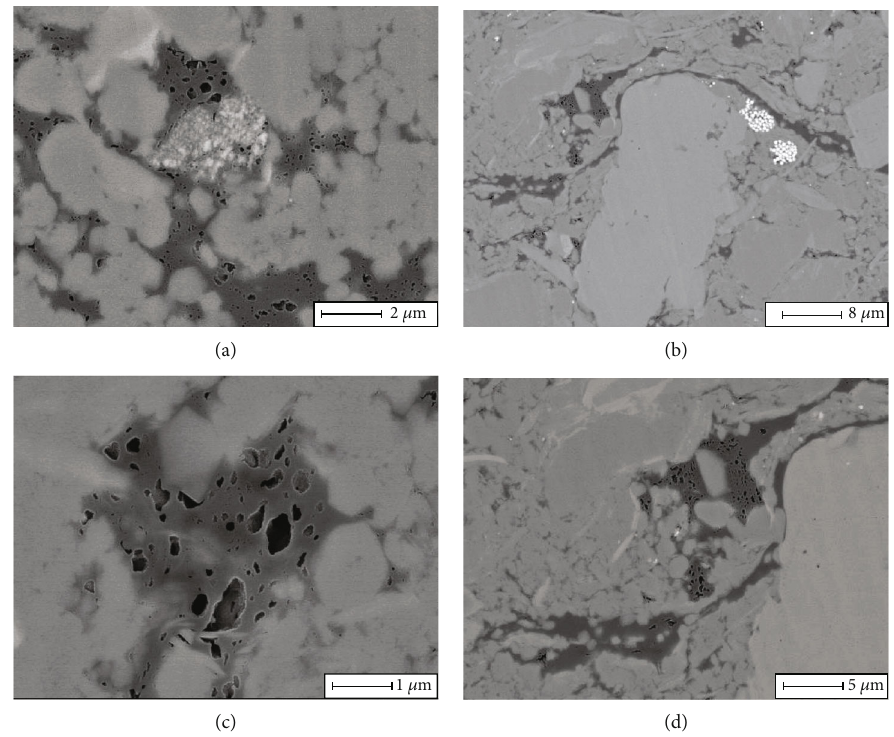
Figure 11: The pore characteristics of pyrobitumen in the Wufeng-Longmaxi Formation shale at the southeast Sichuan Basin.